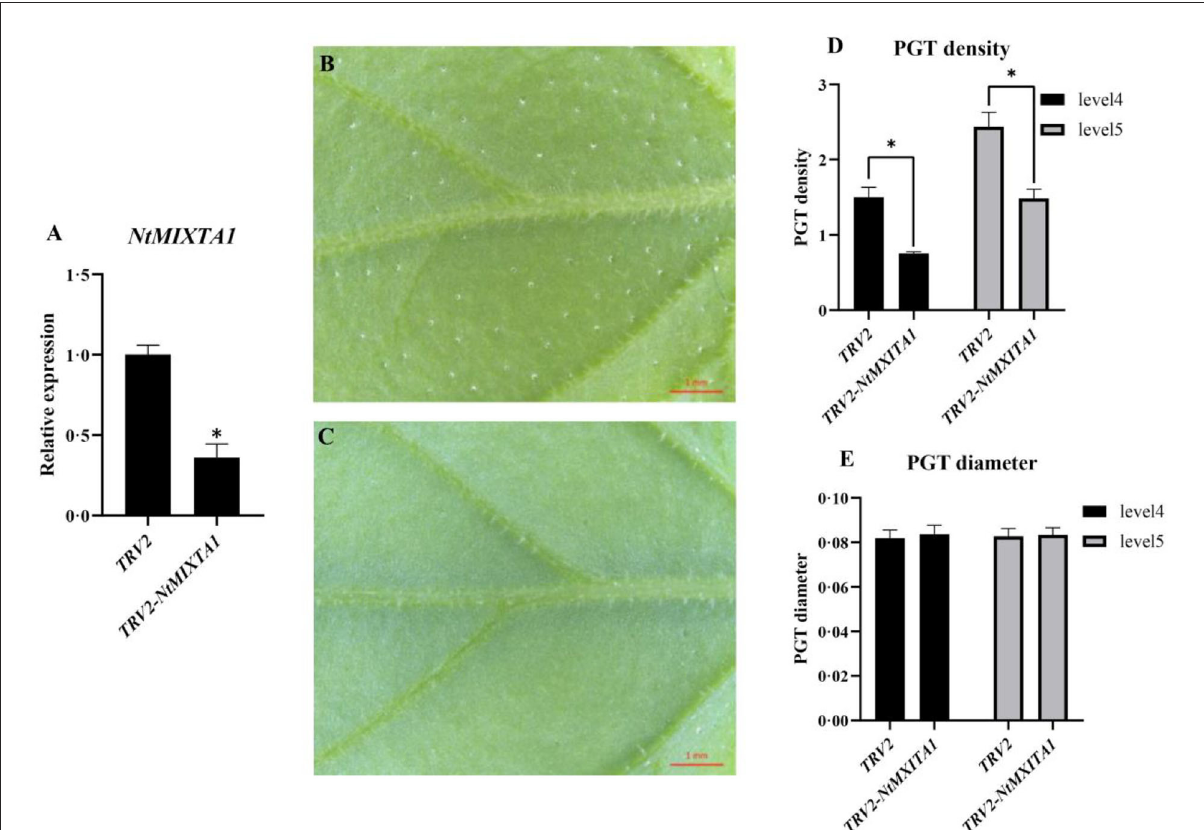
FIGURE3 Gene expression and phenotype analysis of VIGS plants. (A) RT-qPCR analysis of NtMIXTA1 expression with β -actin as a reference gene; the relative expression levels were represented as mean ± SD ( n = 3); phenotypes of pTRV2 (B) and pTRV2- NtMXITA1 (C) showed the presence and decline of PGTs; statistics of PGT density of pTRV2 and pTRV2- NtMXITA1 (D) with p- value < 0.05; statistics of PGT diameter of pTRV2 and pTRV2- NtMXITA1 (E) ; phenotypes, the PGT diameter, and density were represented as mean ± SD ( n = 5). * was represented as p-value <